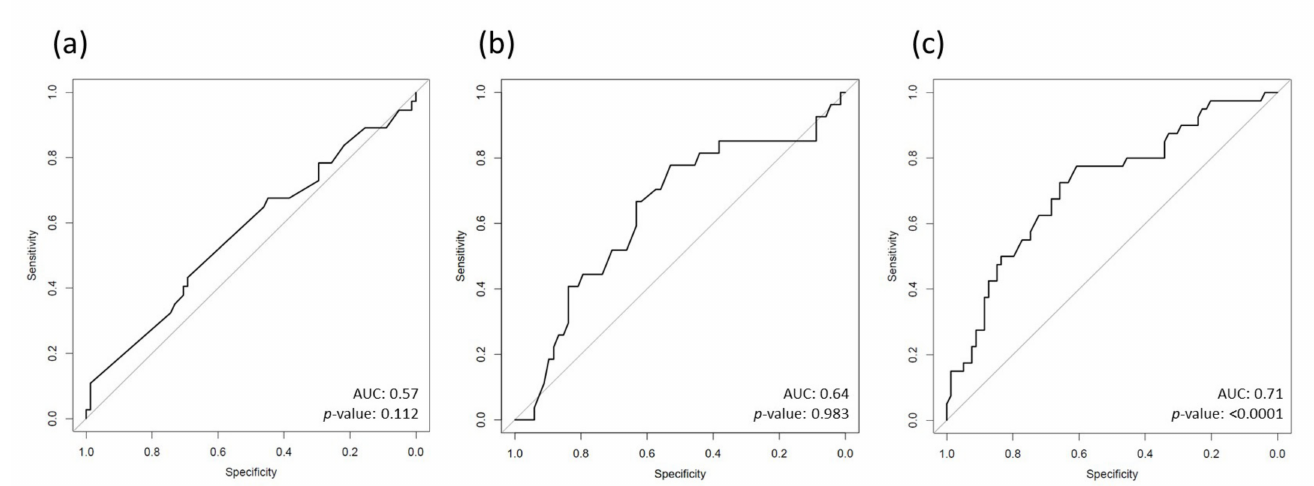
Figure 2. ROC-curves for diagnosis of myocarditis of ( a ) EF, ( b ) E/e‘ and ( c ) TI. Abbrevia- tions: AUC = area under the curve, EF = ejection fraction, TI = Tei index.